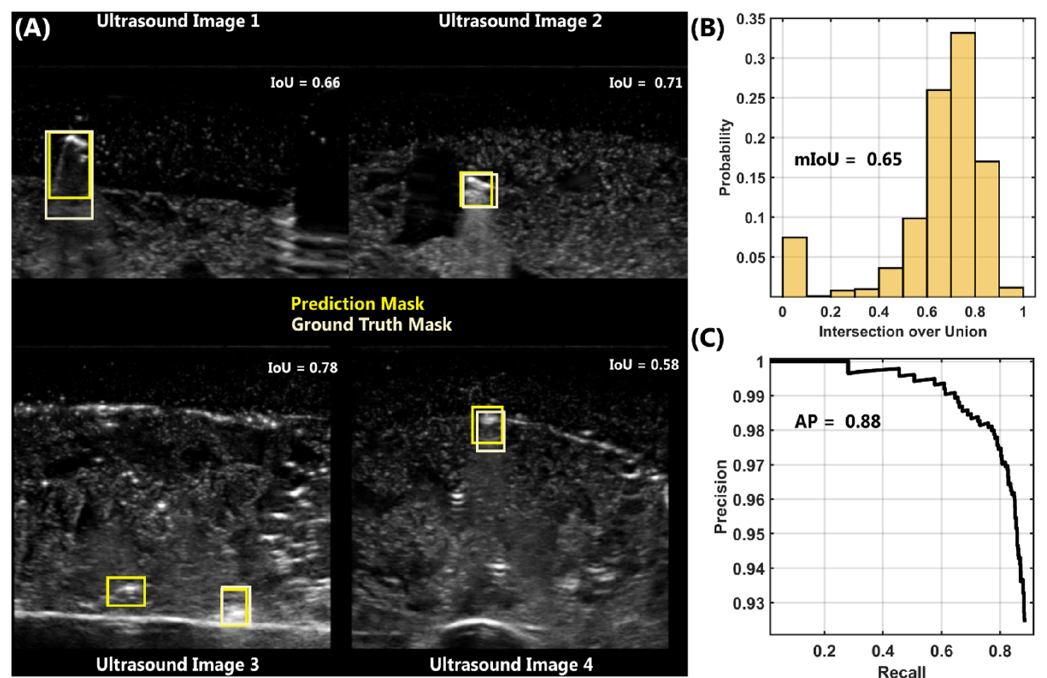
Figure 4. Results for Object Detection in Shrapnel-only Phantom Model. ( A ) Prediction (yellow) and ground truth (light yellow) shrapnel box overlays for four representative ultrasound images in the test data set. IoU scores for each image are shown on each image. ( B ) Probability distribution of IoU scores for test shrapnel data sets. Data is distributed into 10 bins with a mean IoU score of 0.65. ( C ) Precision-recall curve for shrapnel identification by the object detection model. Average precision was 0.88 for this model. Note, the y -axis is zoomed in to 0.93 to 1.0 to better highlight the changes in